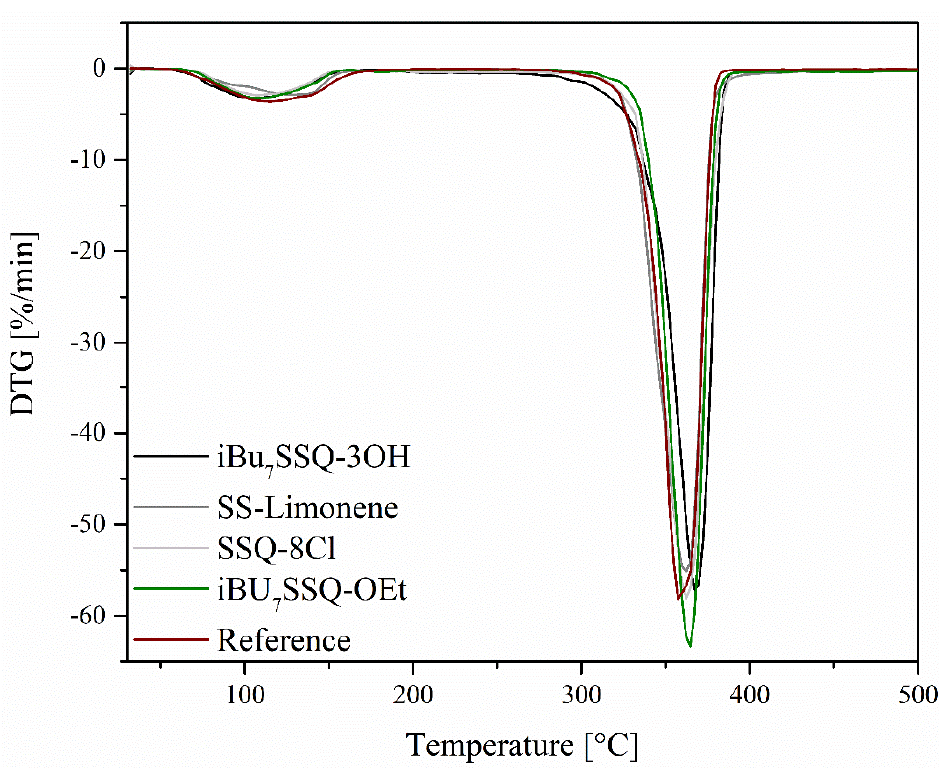
Figure 4. DTG curves of the obtained electrospun materials.